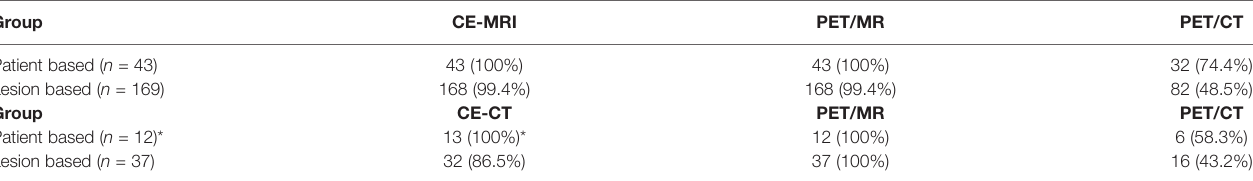
TABLE 2 | Diagnostic accuracy of PET/CT and PET/MR compared with MRI/CT for CRLM.